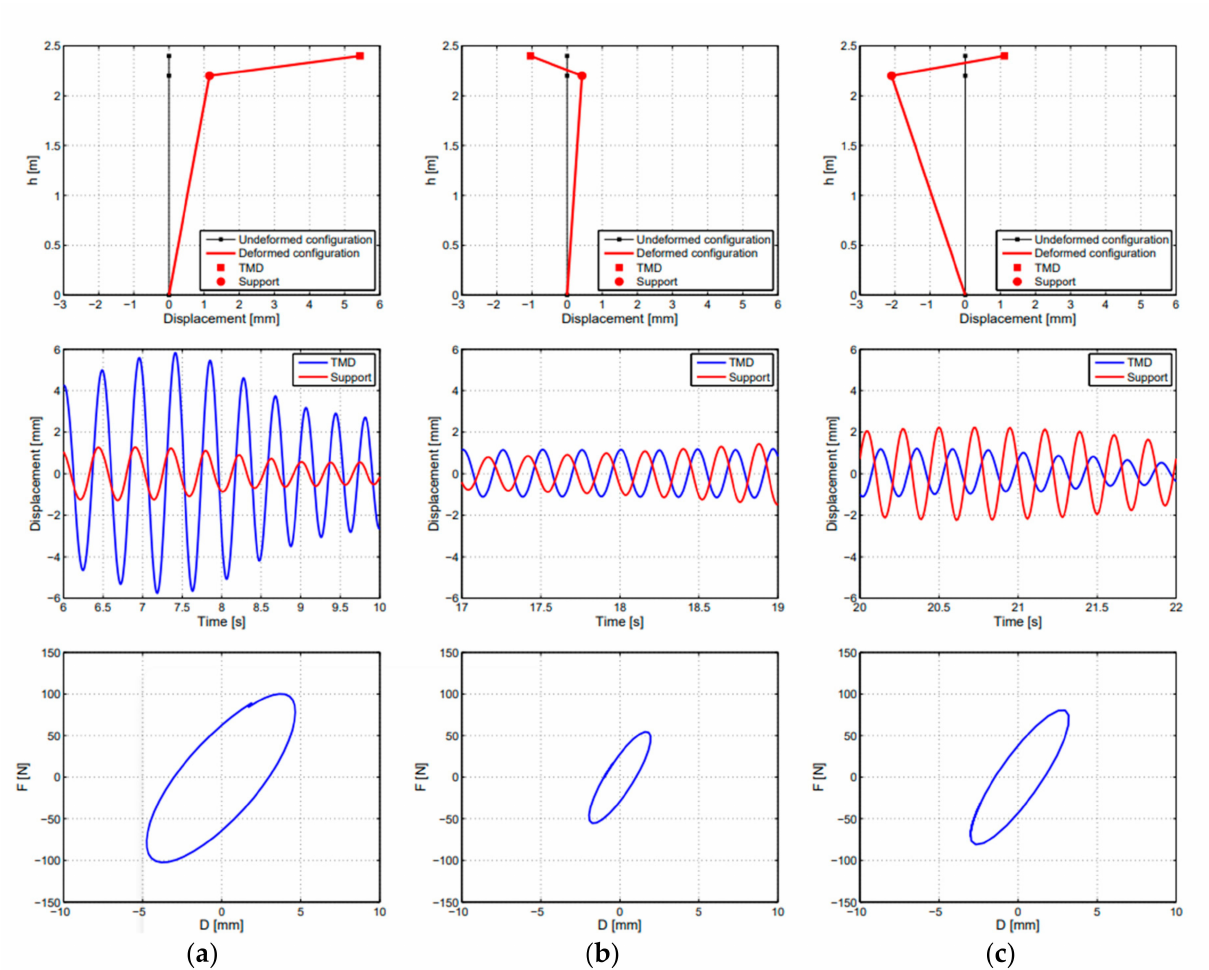
Figure 14. SS. FTMD configuration, detail in the increasing frequency range 1–6 Hz: ( a ) first mode of the FTMD configuration, ( b ) first mode of the F3S configuration, ( c ) second mode of the FTMD configuration. Top: modal displacements vs. structure height; center: TMD and support displacement time history; bottom: force displacement cycles of the HDRB